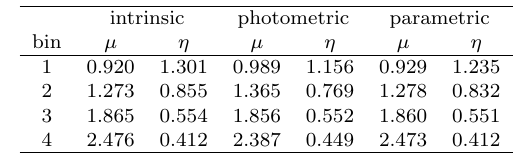
Table 1 Mean µ [Gpc/ h ] and inverse mean η [ h /Gpc] for the intrinsic and photometric source distributions, and the parametric efficiency.